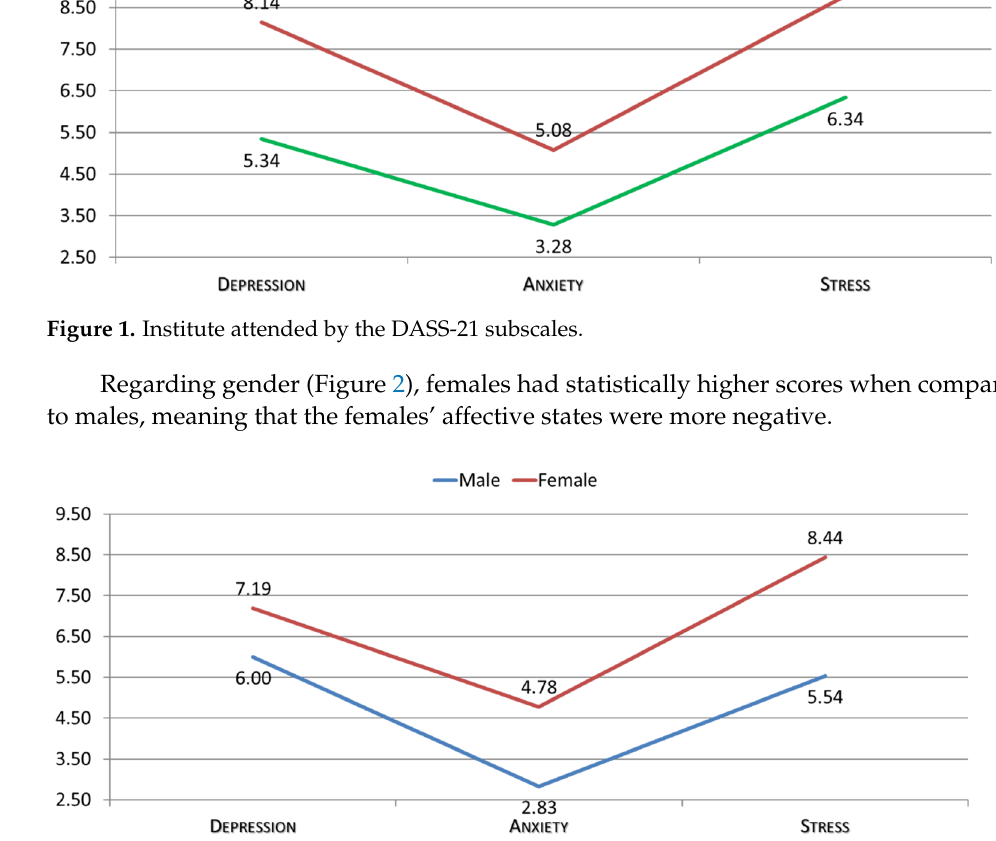
Figure 2. Gender differences in the DASS-21 subscales.